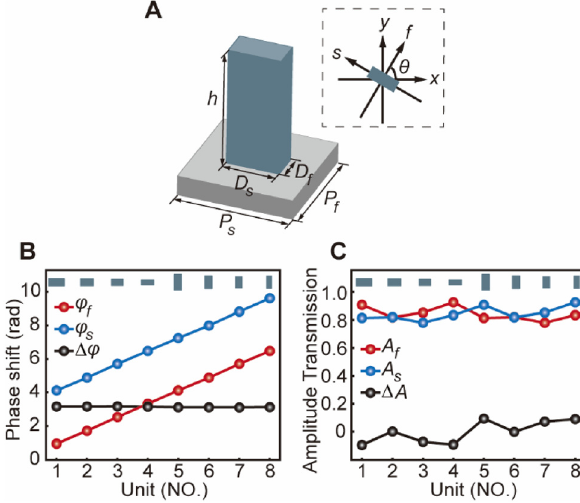
Figure2: Schematicoftheunitsiliconpillarandthesimulatedeigen phase and amplitude responses of the eight selected silicon pillars. (A) The basic unit cell, which is a rectangular-shape silicon pillar patterned on silicon substrate. The inset dashed box illustrates a schematic of the rotation of the unit cell. (B) Simulated eigen phase shiftprofiles φ f and φ s of theeightselectedsiliconpillars,as wellas their phase difference pro fi le Δ φ = φ s – φ f , at 1.0 THz, respectively. (C) Simulated eigen amplitude transmission pro fi les A f and A s of the eight selected silicon pillars, as well as their amplitude difference pro fi le Δ A = A s – A f ,at1.0THz,respectively.Boththetopinsetsin(B) and (C) schematically illustrate the shapes of the eight selected silicon pillars.